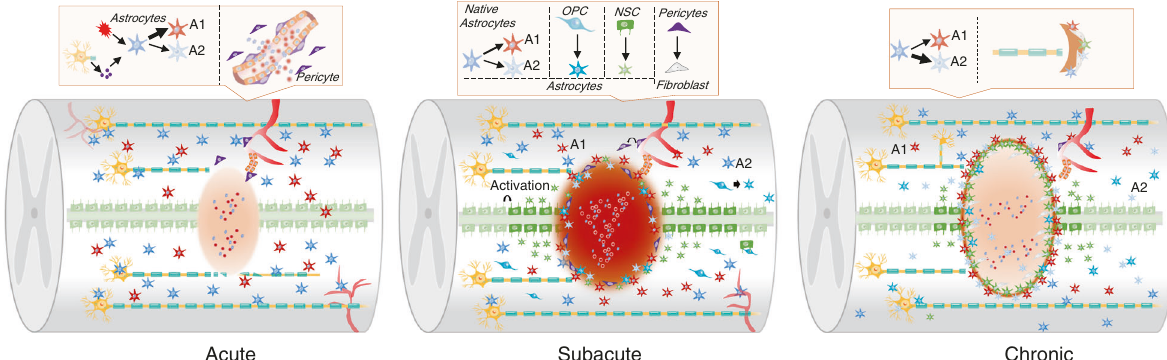
Fig. 2 Scar formation after SCI. This fi gure shows glial scar and fi brotic scar changes in the acute, subacute, and chronic phases. In the acute phase of SCI, astrocytes are polarized toward the A1 and A2 phenotypes, and pericytes derived from blood vessels migrate into the injury epicenter. In the subacute phase of SCI, a scar is formed by astrocytes derived from native astrocytes, oligodendrocyte progenitor cells (OPCs) and neural stem cells (NSCs). In this stage, fi broblast-derived pericytes seal the scar. In the chronic phase of SCI, the scar is stable, limits in fl ammation and suppresses the regeneration of